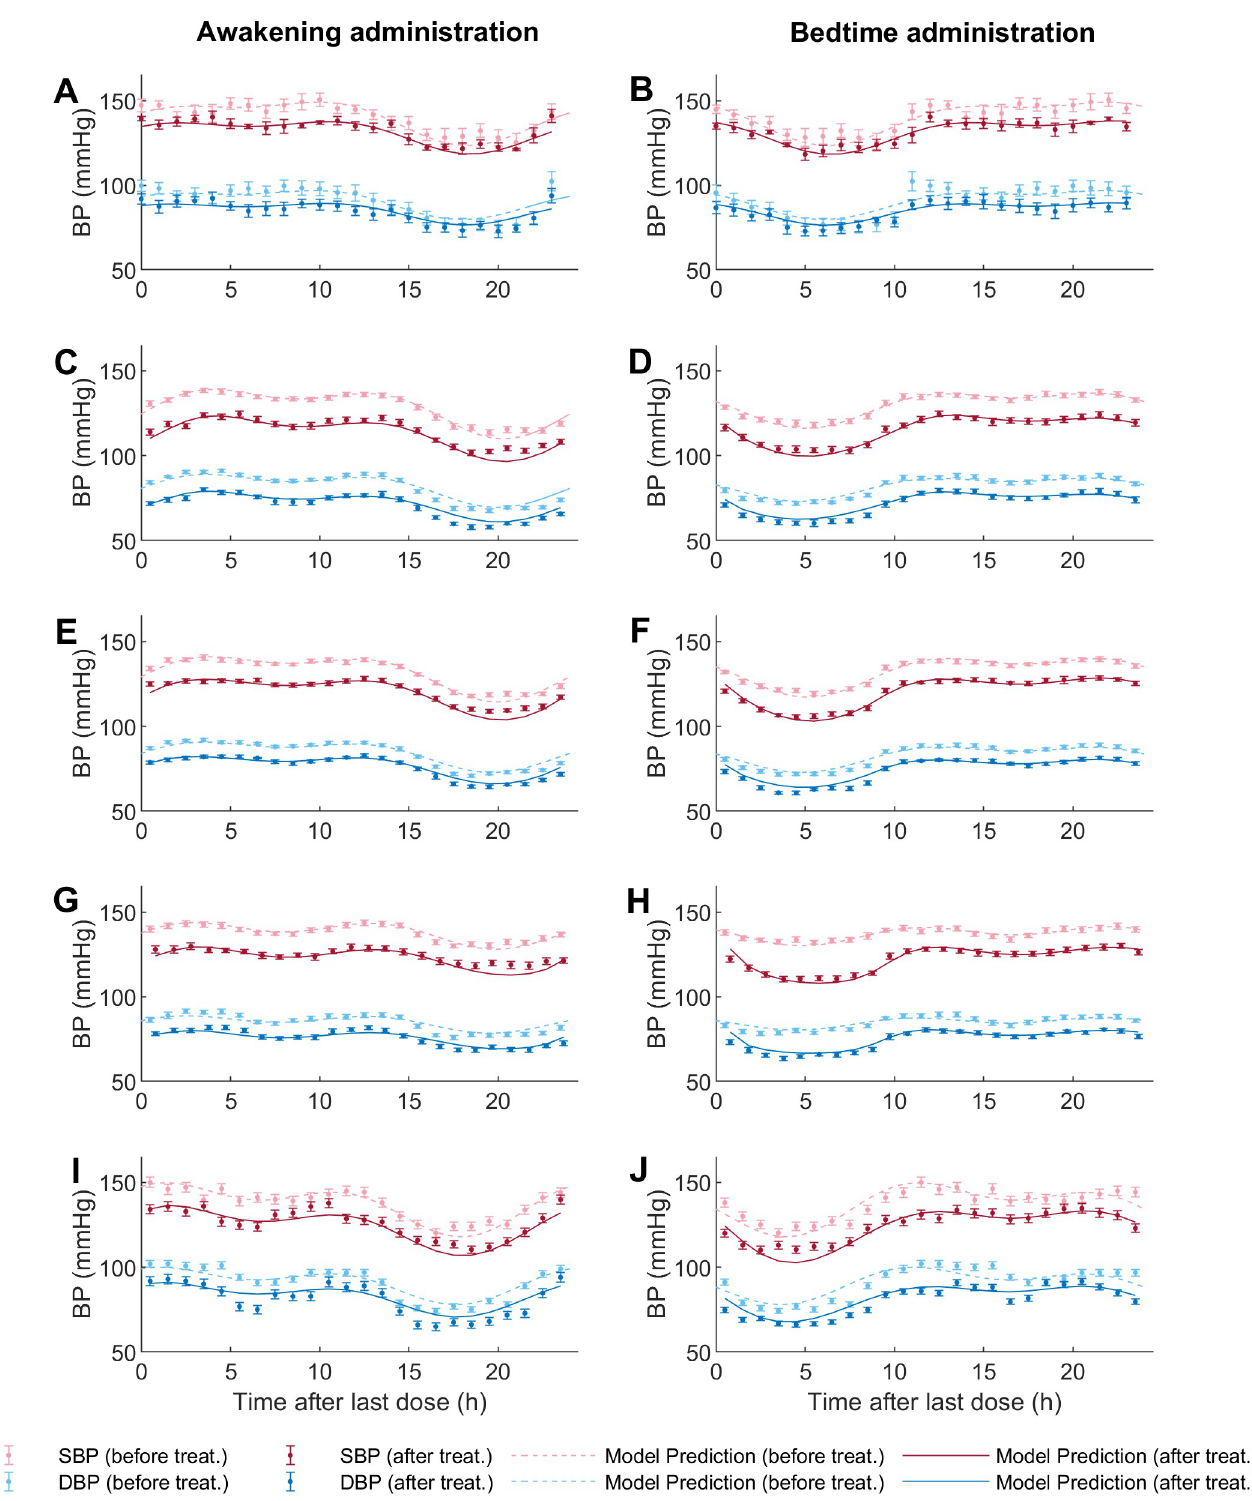
Fig 2. Model fitting to the experimental data for non-prodrug models. The figures on the left correspond to awakening/morning administration and on the right to bedtime/evening administration. Each figure shows data with their respective standard errors (SE) for SBP before treatment (light red dots) and DBP (light blue dots), and for SBP after treatment (dark red dots), DBP (dark blue dots). The dotted line represents the model prediction before treatment, and the solid line represents the model prediction of each model after the last dose. Fig 2A and 2B, amlodipine; Fig 2C and 2D, olmesartan; Fig 2E and 2F, telmisartan; Fig 2G and 2H, valsartan; Fig 2I and 2J, lisinopril.